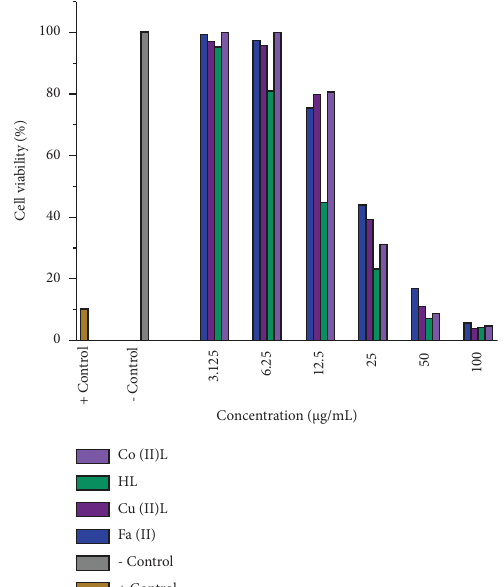
Figure 12: Te percentage of the cell viability calculated using the MTTassay in liver cancer cells (HepG2) for the azo dye ligand (HL) and its Cu(II), Co(II), and Fe(II) complexes after 24h of incubation at various concentrations compared with the positive and negative controls. Table 7: DNA fragmentation of (a) azo ligand and its (b) Cu(II), (c) Co(II), and (d) Fe(II) complexes at (0.1, 1 μ g/mL) on HepG2 cells.